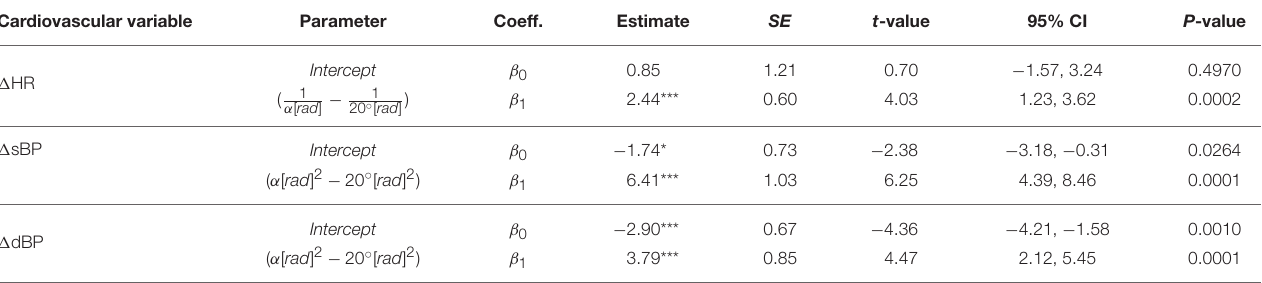
TABLE 2 | Statistical models for 1 HR, 1 sBP, and 1 dBP responses to PE without and with FES. Cardiovascular variable Parameter Coeff.